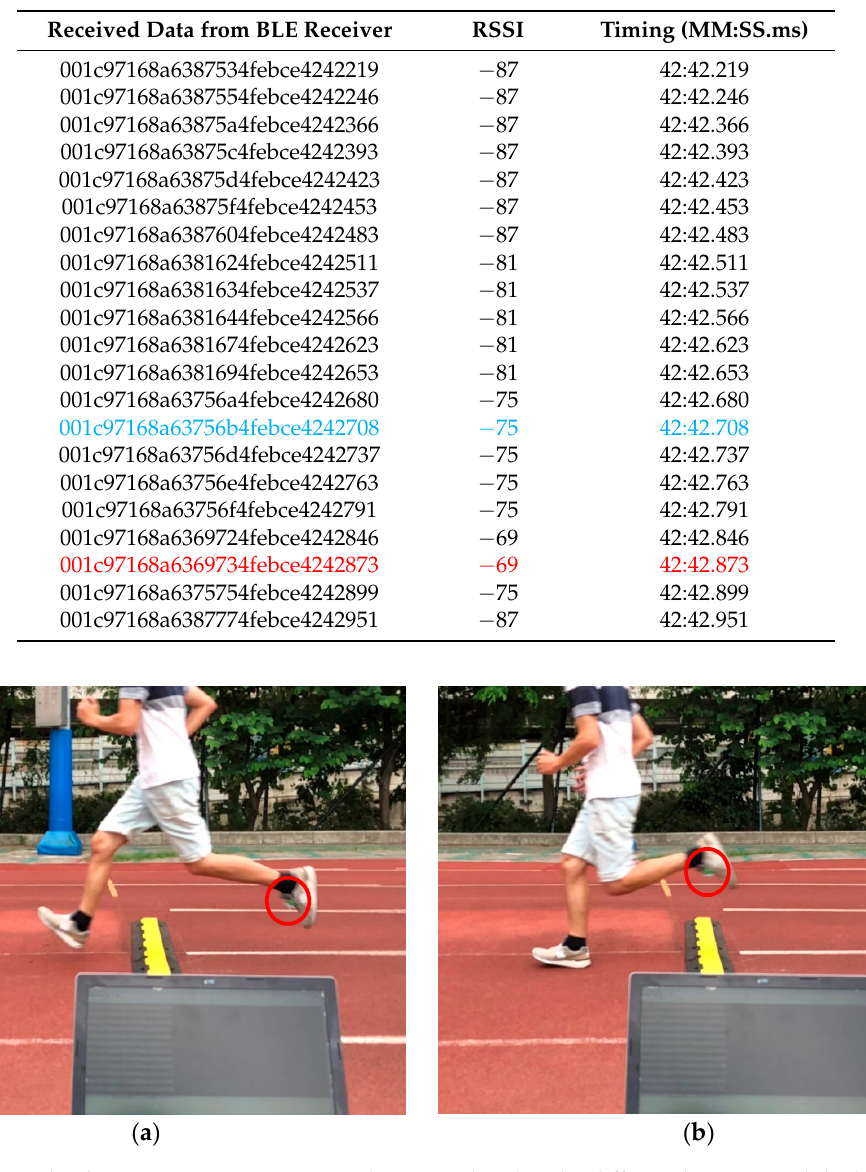
Figure 15. The dynamic experiment to test the RSSI related to the different locations, while the BLE Tag is on the instep. ( a ) Shows the time of the runner on top of the mat. ( b ) Shows the time at which the biggest RSSI was received. Table 6. One dynamic experiment in which the BLE Tag was on the chest.